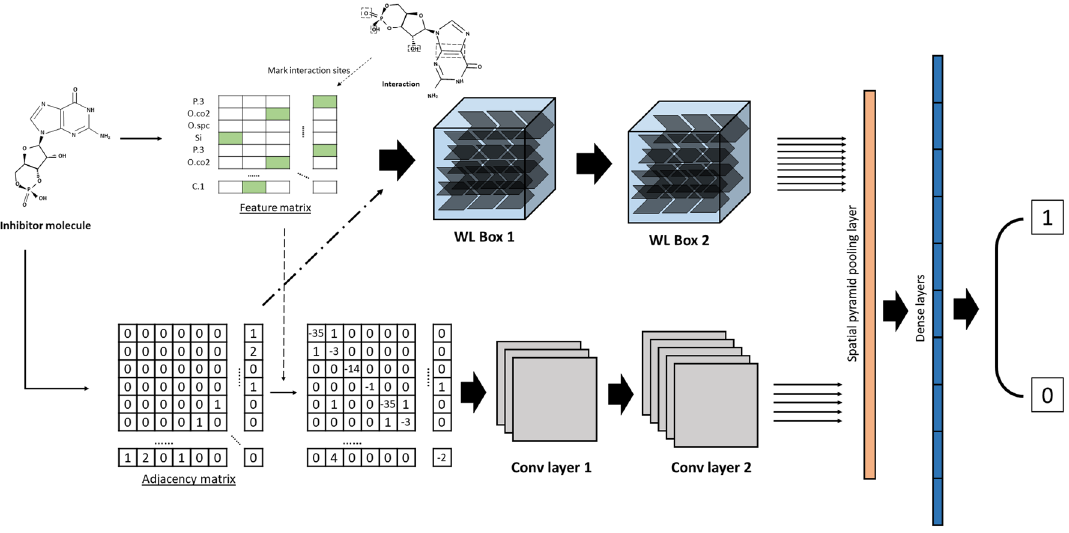
Figure 4. Architecture of the PISPKI